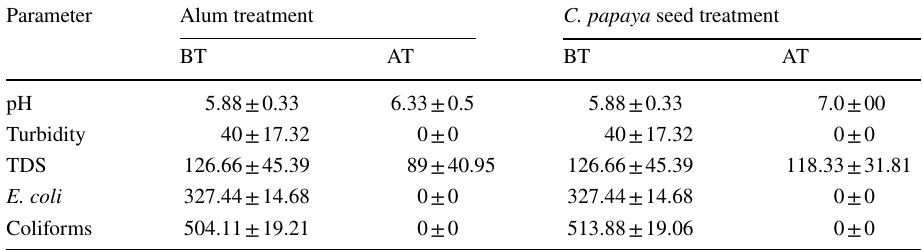
BT before treatment, AT after